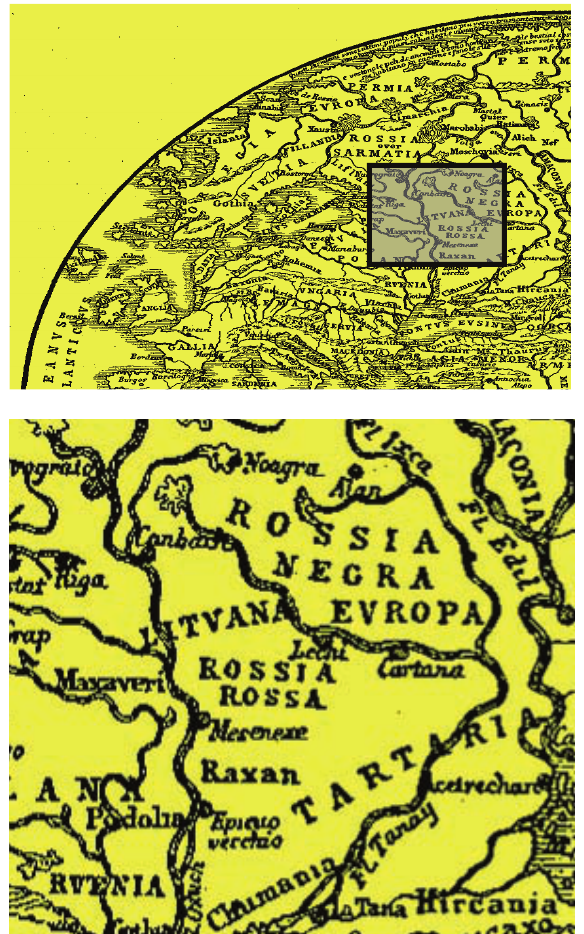
Fig. 8. Part of the Fra Mauro´s map of the world and its fragment (1459) (on line copy, the original map is located in Venice Mariana library)